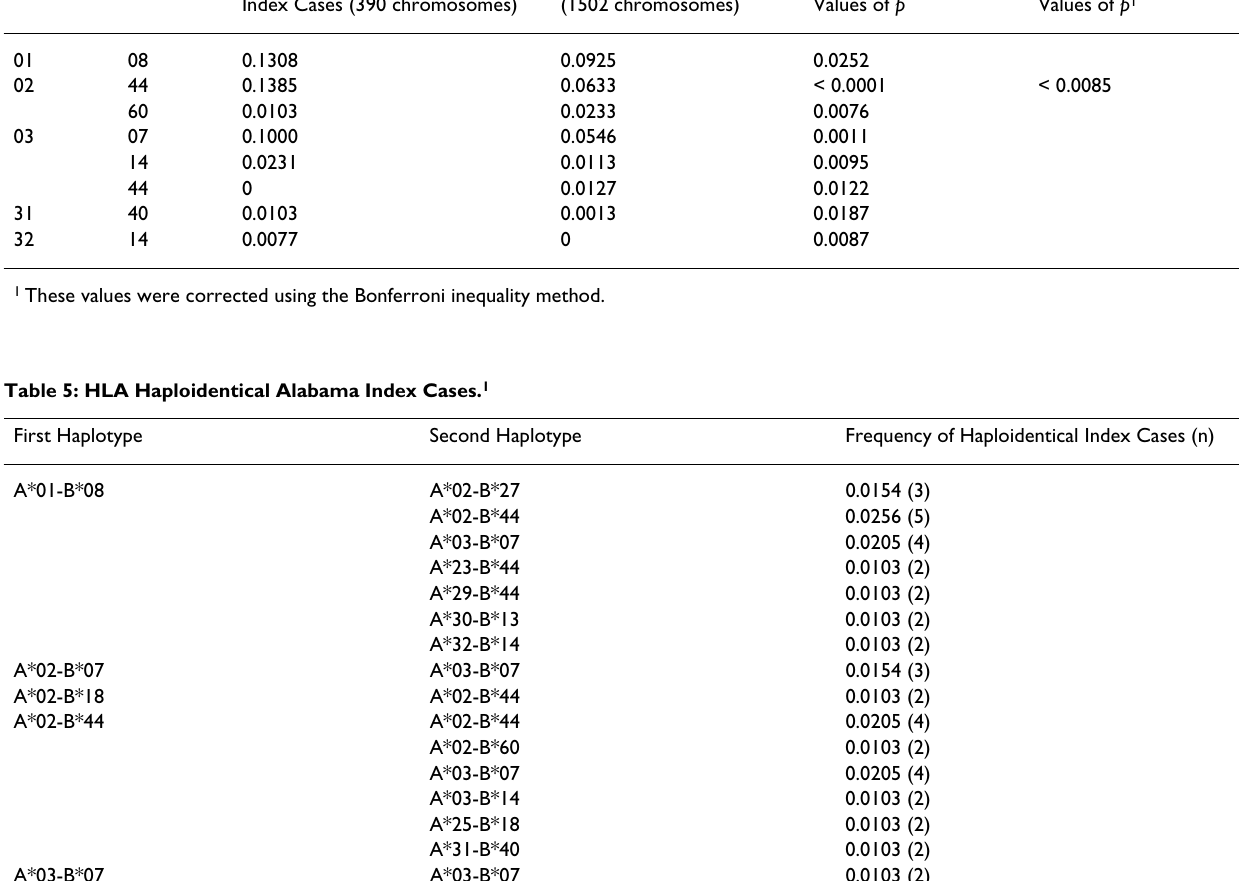
Table 4: HLA-A and -B Haplotypes in Alabama Subjects. HLA-A